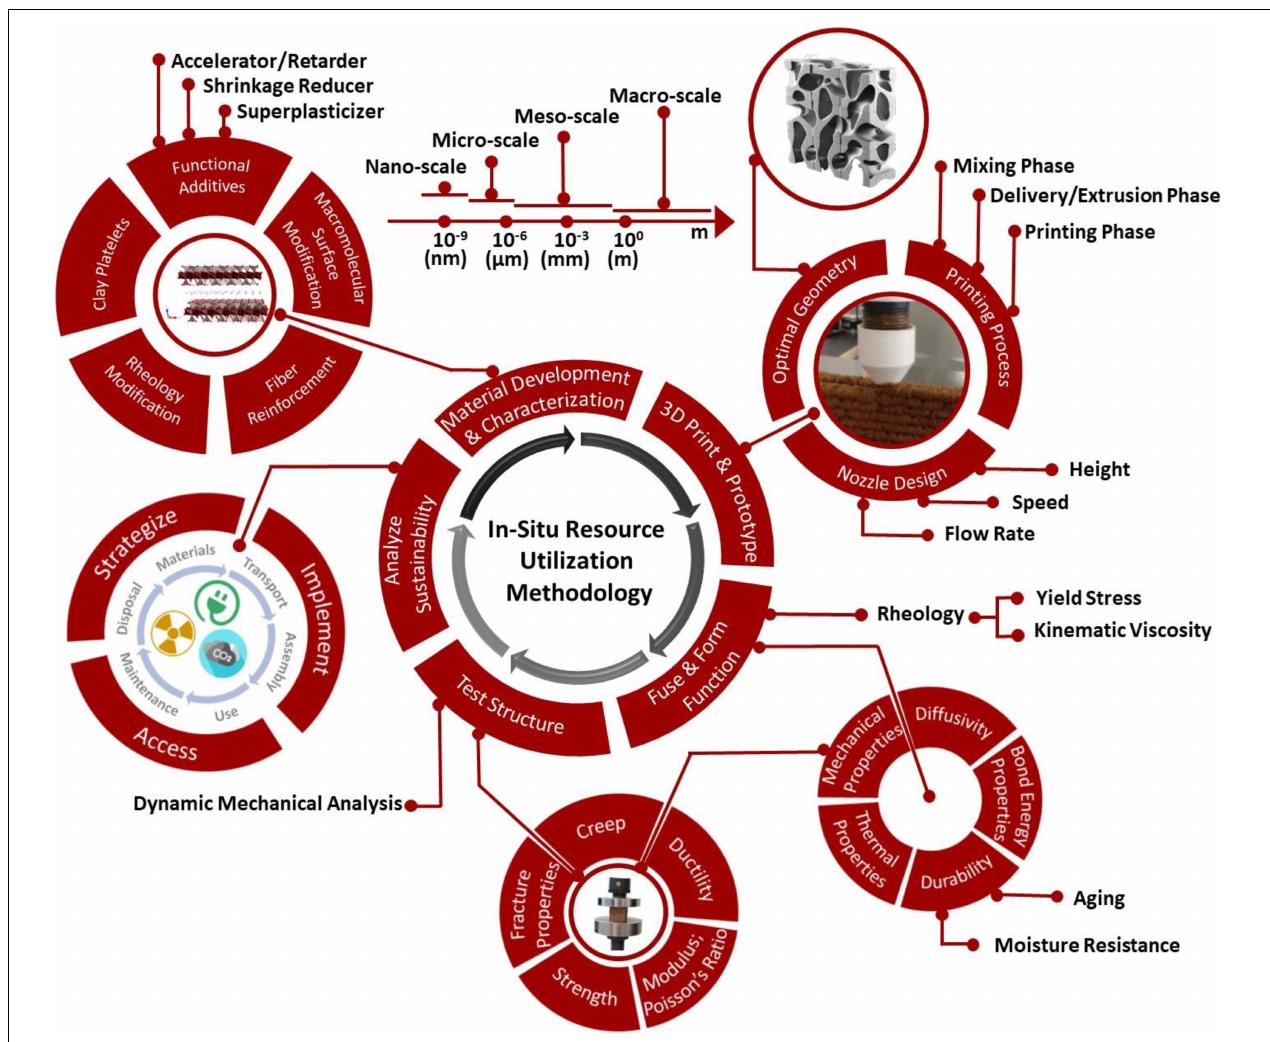
FIGURE 1 | Schematic representation of a proposed process flow for in situ resource utilization. The approach depicts the multiscale design of a palette of sustainable 3D-printable construction materials that address a critical imperative for sustainable utilization of the earth’s limited resources. This strategy brings together materials development, assessment of printability and buildability, with embedded multifunctionality. Material development efforts are focused on the utilization of naturally sourced clay platelets through surface modification and fiber reinforcement. The modified soil is rendered extrudable by developing hybrid admixtures with the appropriate rheology; 3D printing and prototype development efforts enable exploration of generative design concepts. The fusion of form and function in test structures yields a vastly expanded scope for embedding novel functionality through geometric design whilst achieving economy of materials use. An integrated framework involving evaluation of rheology and printability, assessment of desired function such as load bearing properties and stability, and life cycle assessment enables iteration and successive improvement of all metrics.